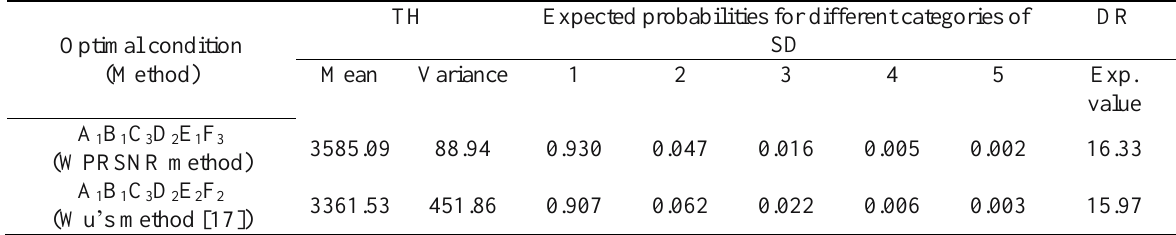
Table 3. Expected values of different responses under the two optimal process conditions.